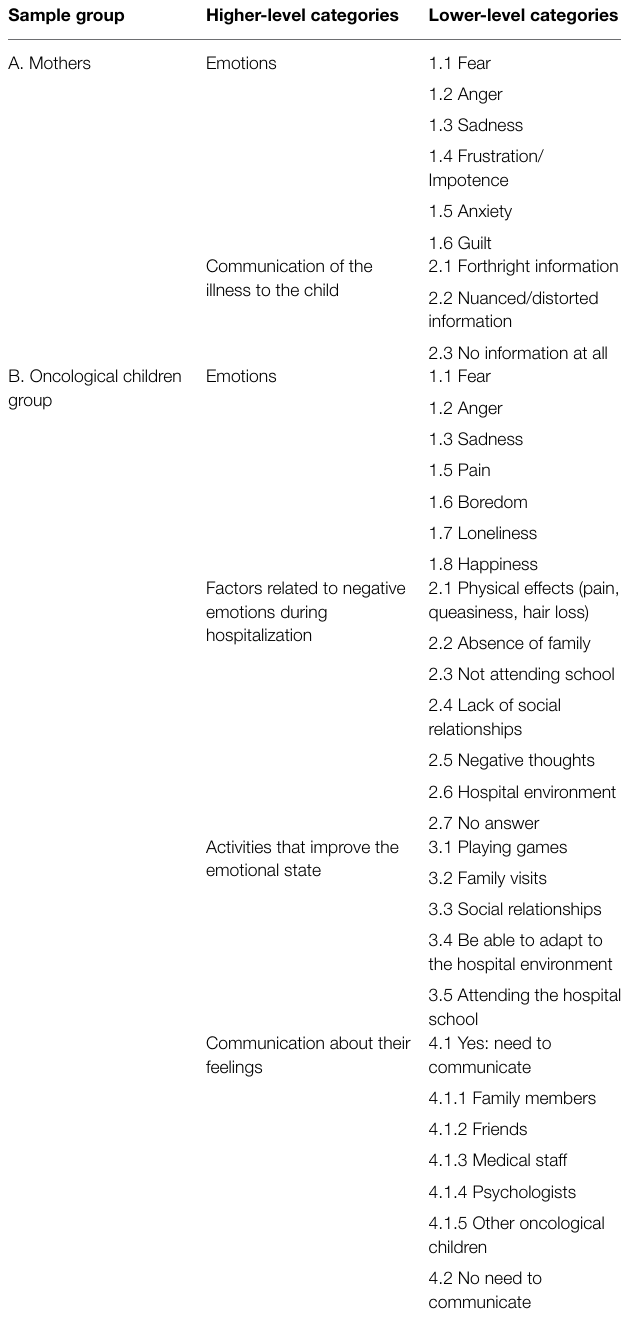
TABLE 2 | Coding categories of the semi-structured interviews to the family and the children. Sample group Higher-level